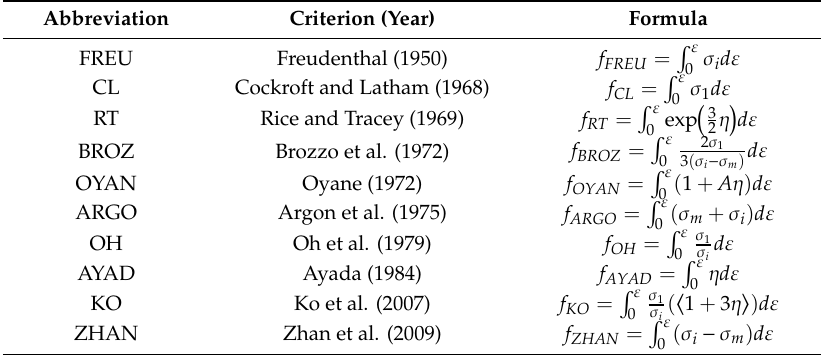
Table 1. Selected criteria of ductile fracture used for the presented analysis [21–30].